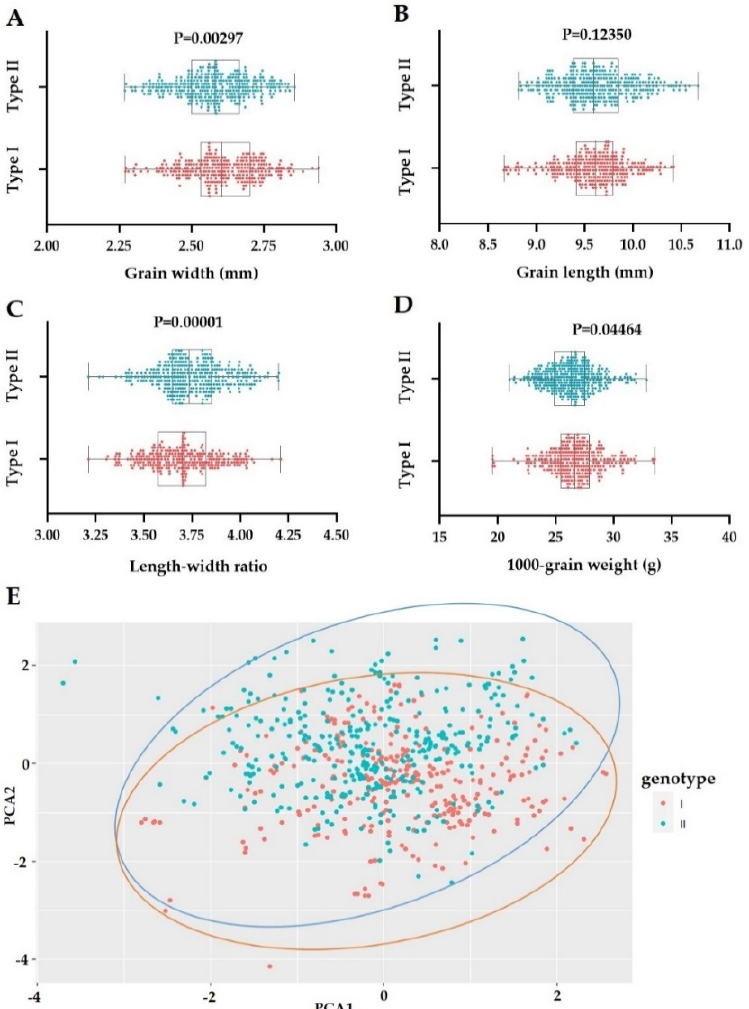
Figure 3. Validation of qLWR-12c / qGW-12 by comparing groups genotyping by 12–26 in F 10 progeny. ( A – D ) Denote compare of two groups for grain width, grain length, length-width ratio, and 1000-grain weight, respectively. ( E ) Clustering analysis for all grain shape related traits in two groups with the opposite allele of qLWR-12c / qGW-12 . Type Ⅰ and Type Ⅱ mean Nei2B-type and R8006-type at 12–26, respectively.